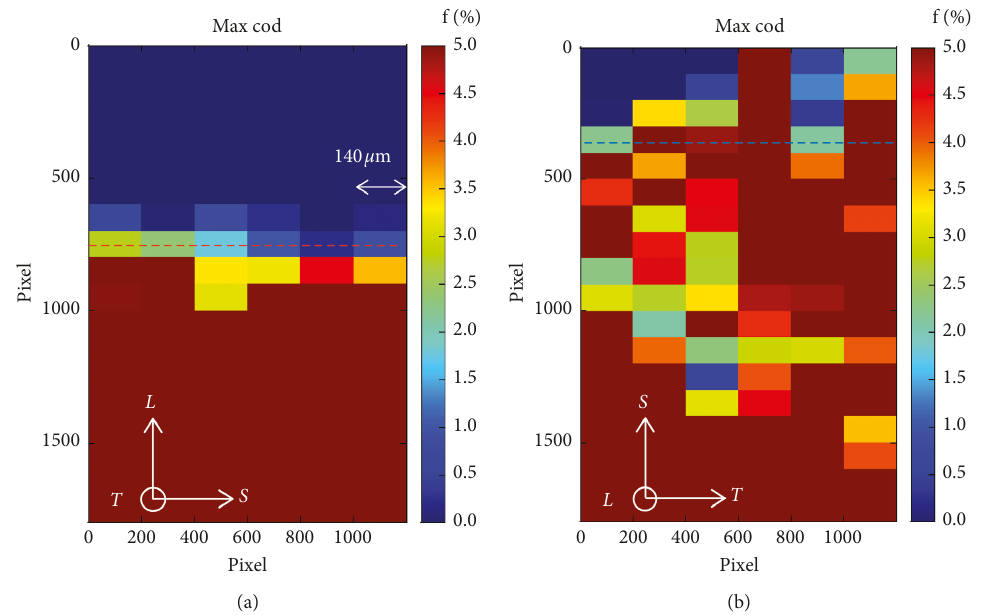
Figure 10: Void volume fraction map in region of interests (ROI) � 140 × 140 × 70 μ m 3 for configurations (a) TL and (b)